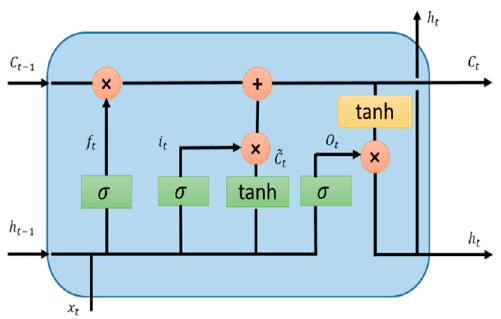
Figure 30. Diagram for Long Short-Term Memory (LSTM).